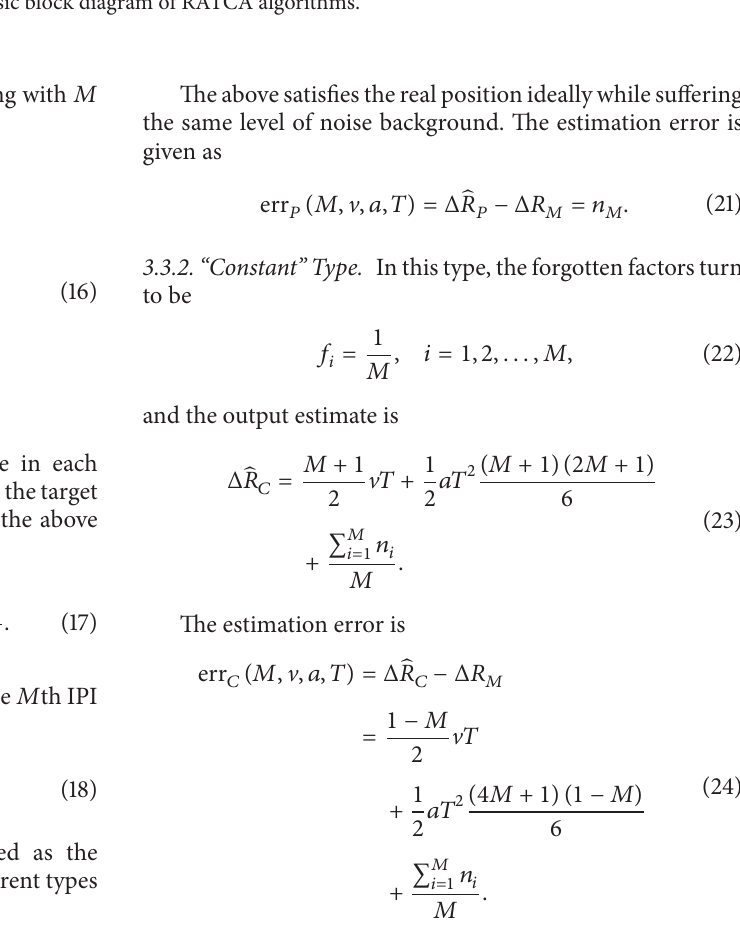
Figure 8: Basic block diagram of RATCA